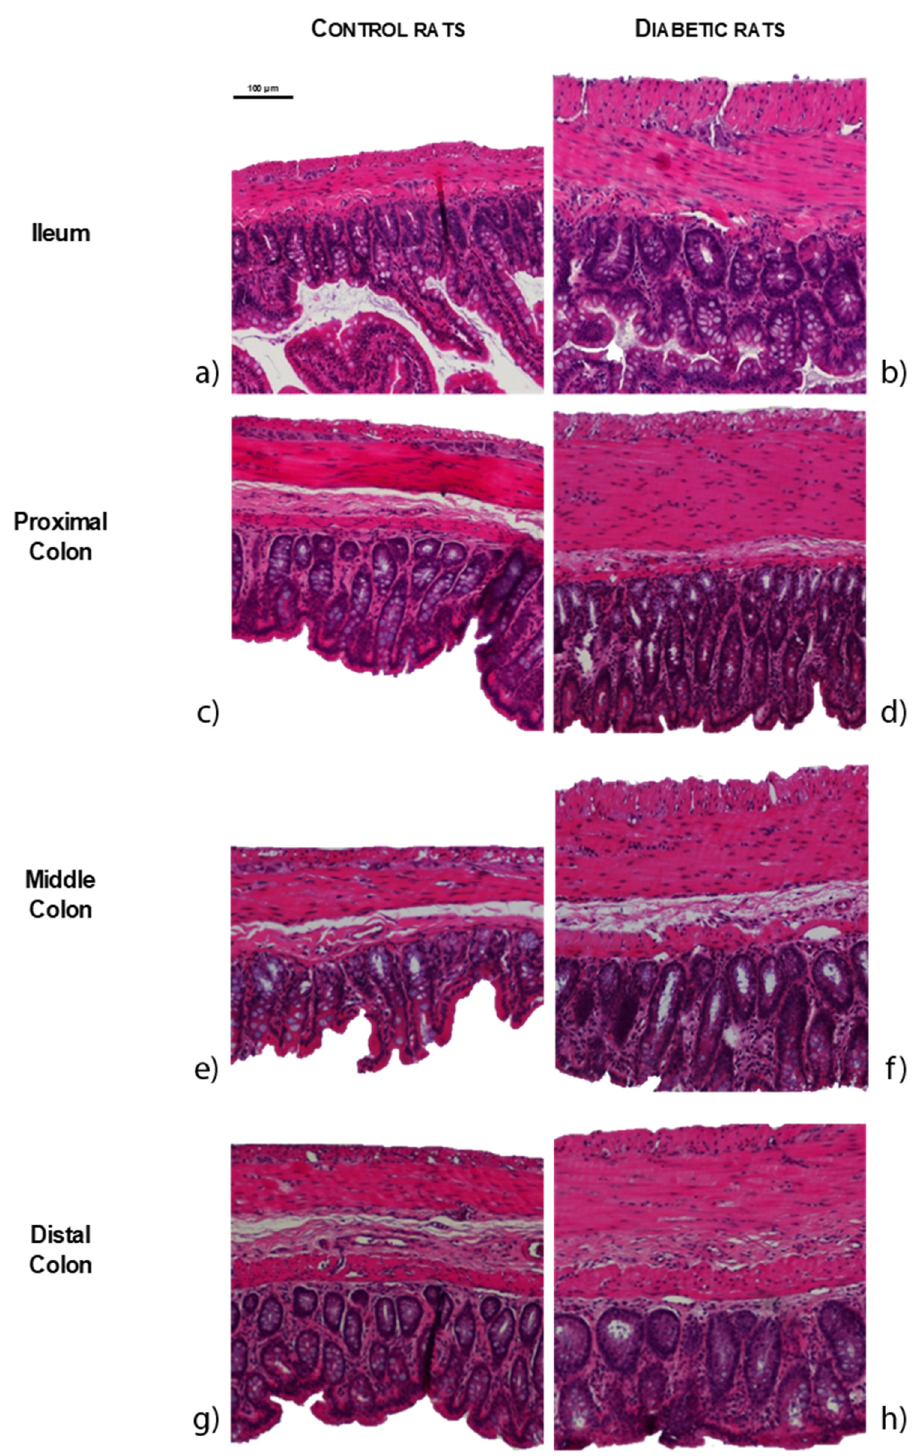
Figure 3. Representative microscopic photographs of intestinal segments of control (CTRL, a , c , e , g ) and streptozotocin-induced diabetic rats (STZ, b , d , f , h ), stained with hematoxylin and eosin: ileum ( a , b ); proximal colon ( c , d ); middle colon ( e , f ) and distal colon ( g , h ). The scale bar (100 µm) is valid for all images.